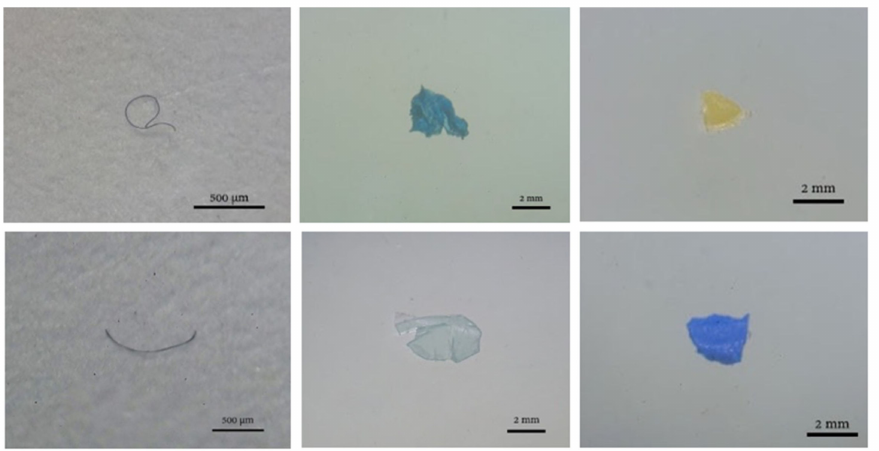
Figure 5. Examples of microplastic shapes collected from the beach sediment on the eastern Gulf Coast.